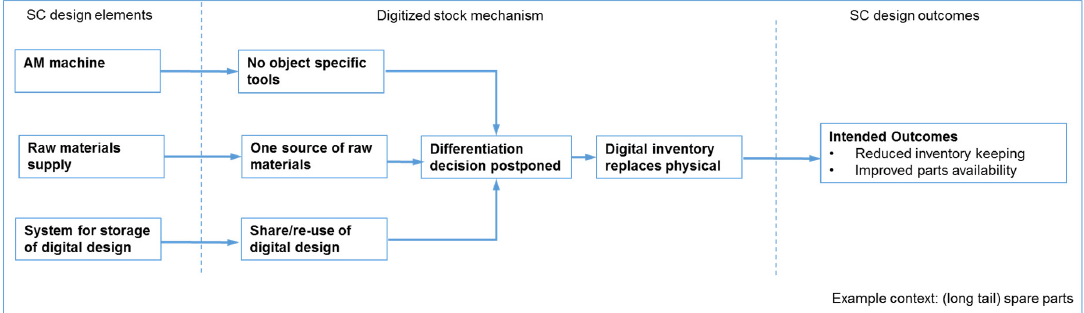
Figure 5. Digitized stock mechanism.